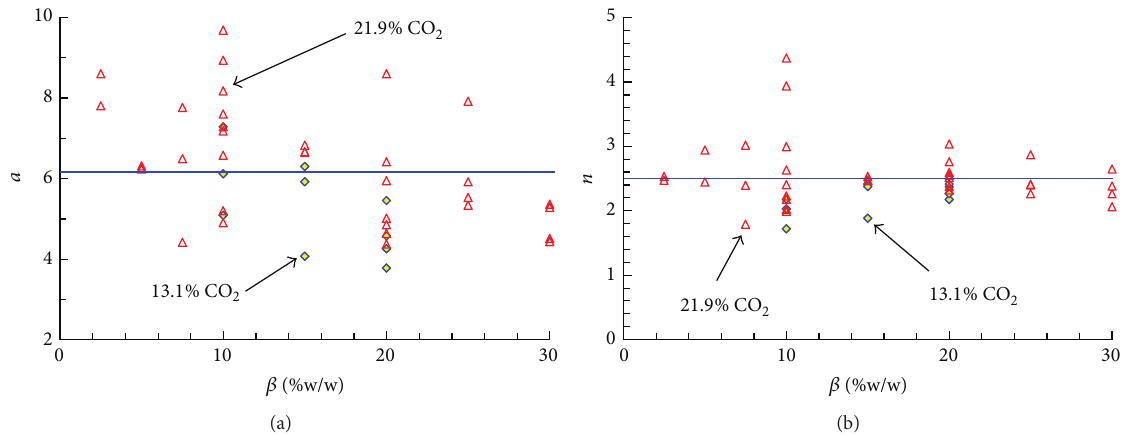
Figure 5: Results of curve fitting of CO 2 concentration to (6). The efficiency factor ( 𝑎 ) is plotted on the left and the form factor ( 𝑛 ) is plotted on the right as function of the aqueous MEA concentration. The blue horizontal line indicates the corresponding average